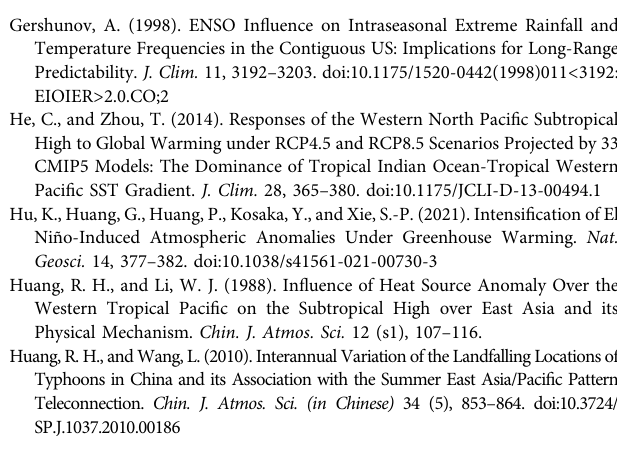
, ver1-2, − ω Ep · z Δ q z , ver1-3, − ω E · z Δ q z , ver2-1, − ω p · z Δ q E z , ver2-2, − Δ ω · z q Eq z , ver3-2, − Δ ω · z Δ q E z ) over SEA (A) and p p p p p p